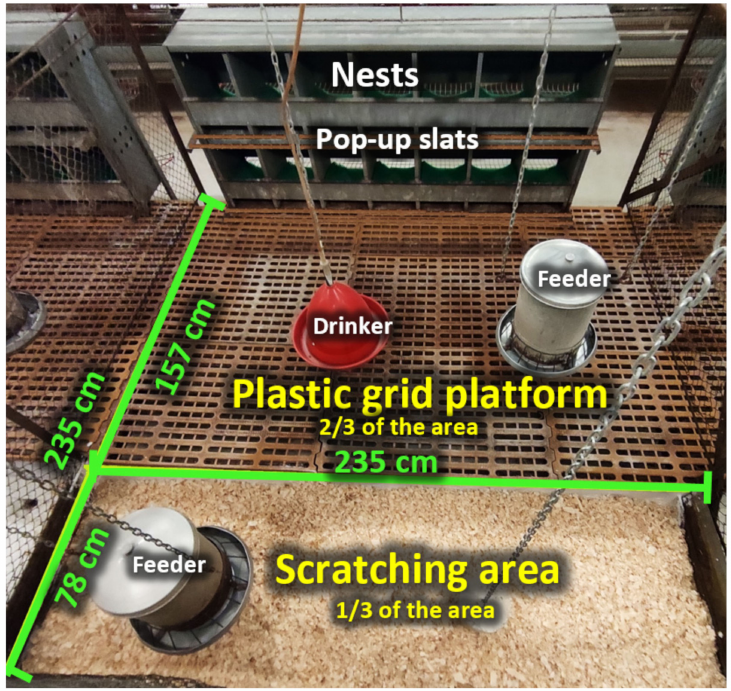
Figure 2. The floor plan of the alternative pen and the layout of the technological devices.